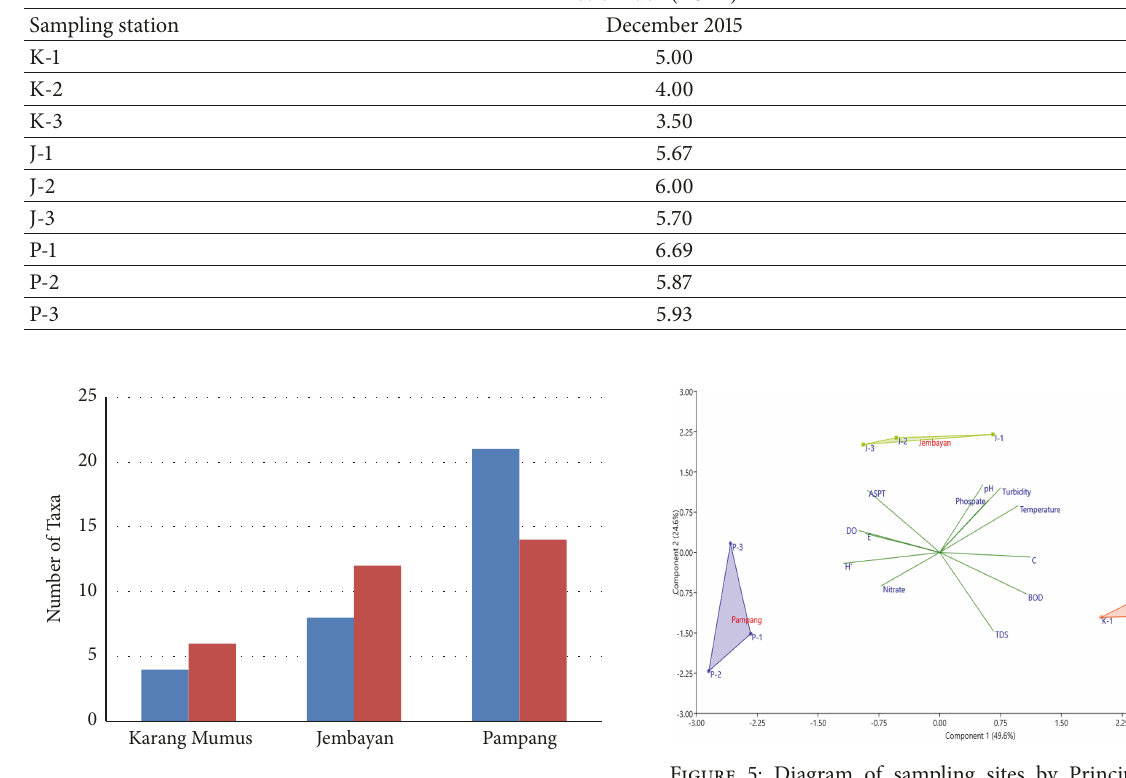
Table 4: Biotic index (ASPT) of benthic macroinvertebrates in all sampling locations. Biotic Index (ASPT)